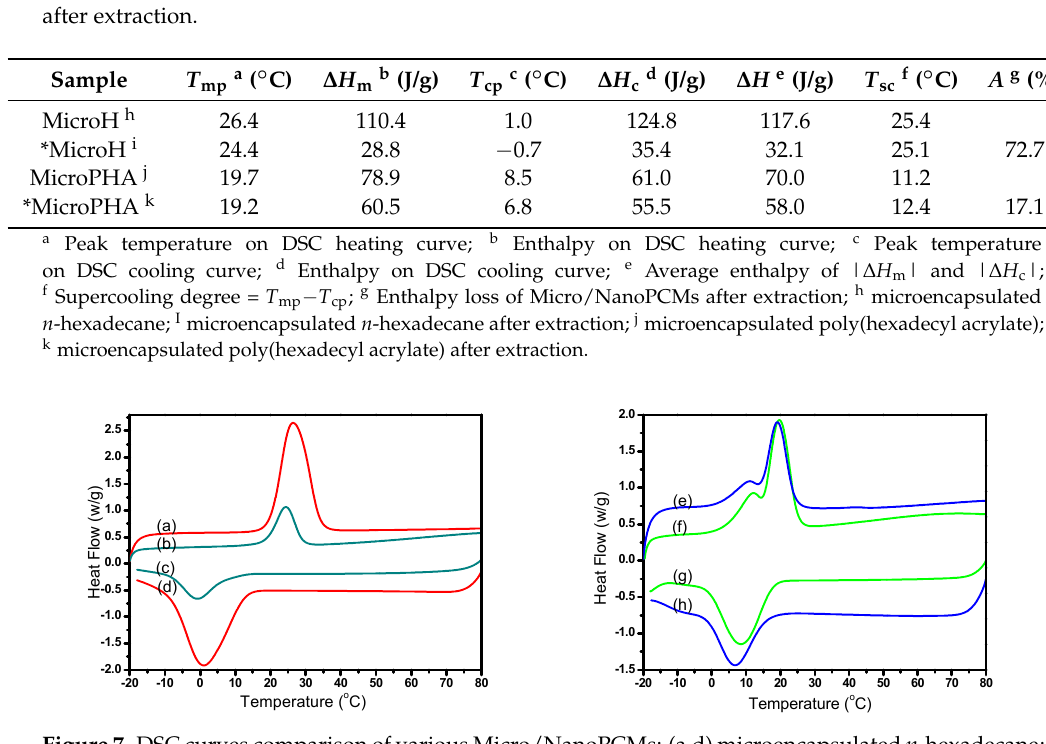
Figure 7. DSC curves comparison of various Micro/NanoPCMs: (a,d) microencapsulated n -hexadecane; (b,c) microencapsulated n -hexadecane after extraction by alcohol; (f,g) microencapsulated poly(hexadecyl acrylate); and (e,h) microencapsulated poly(hexadecyl acrylate) after extraction by alcohol.